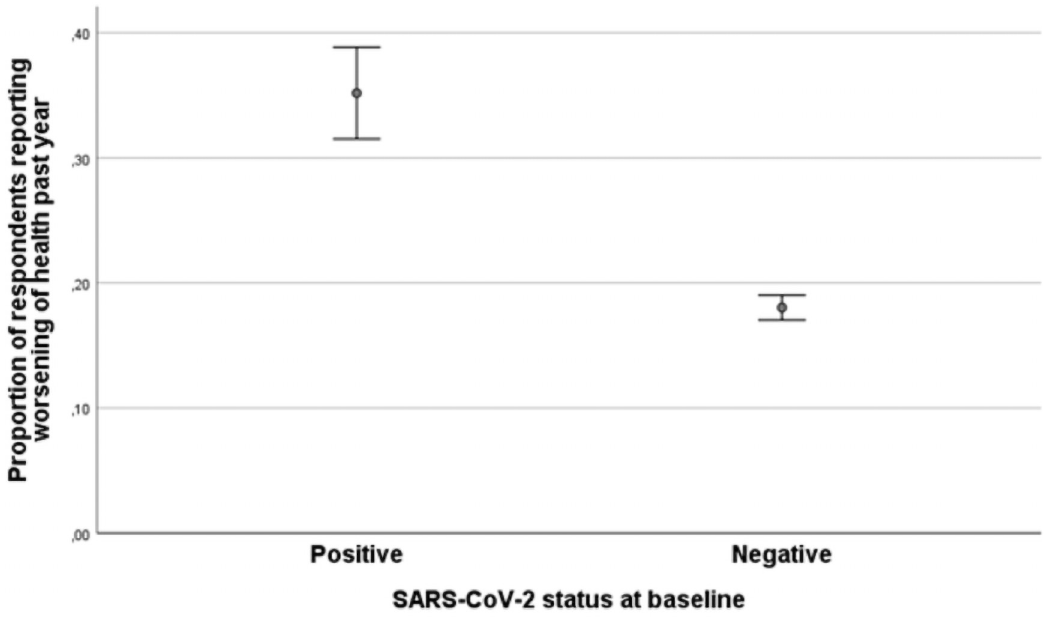
Fig 1. Proportion of participants reporting a worsening of health past year at 3–8 months after baseline. The figure shows the proportion of participants reporting a “somewhat” or “much” worse health than one year ago at the time of follow-up. SARS-CoV-2 positive or negative status was based on RT-PCR at Norwegian accredited laboratories at baseline. Error bars are 95% confidence intervals for the